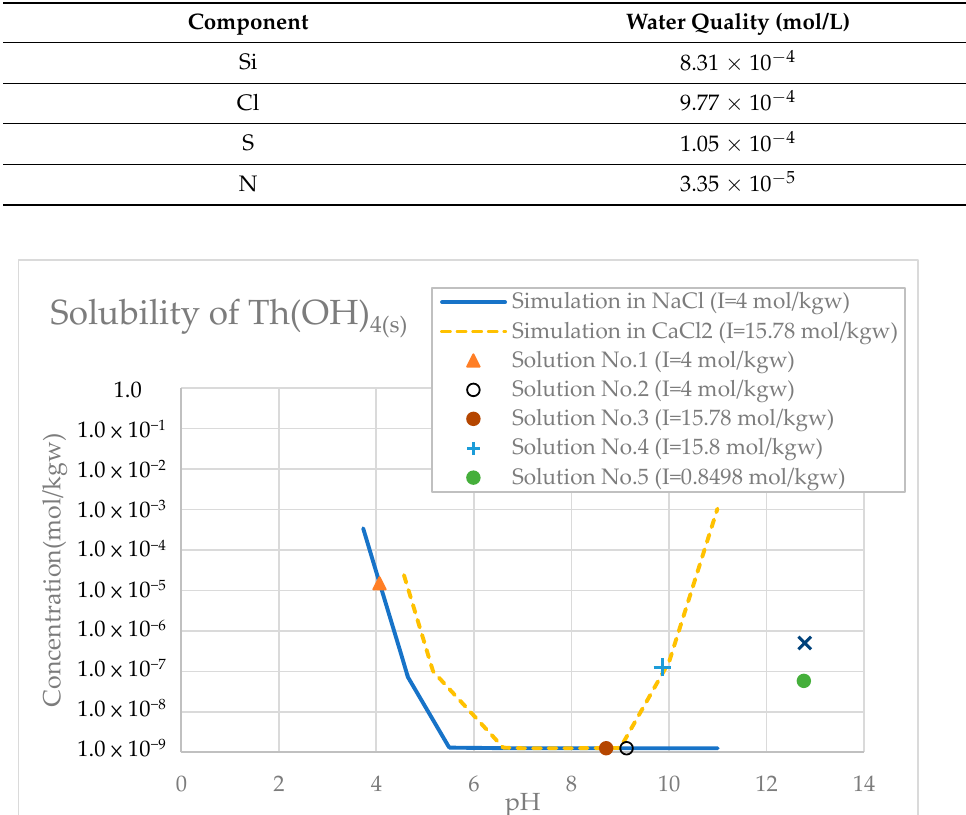
Figure 3. Comparion of the total dissolved concentration of Th(OH) 4(s) in relation to pH, as calculated using the data of solutions No.1, 2, 3, 4, 5 and 6.